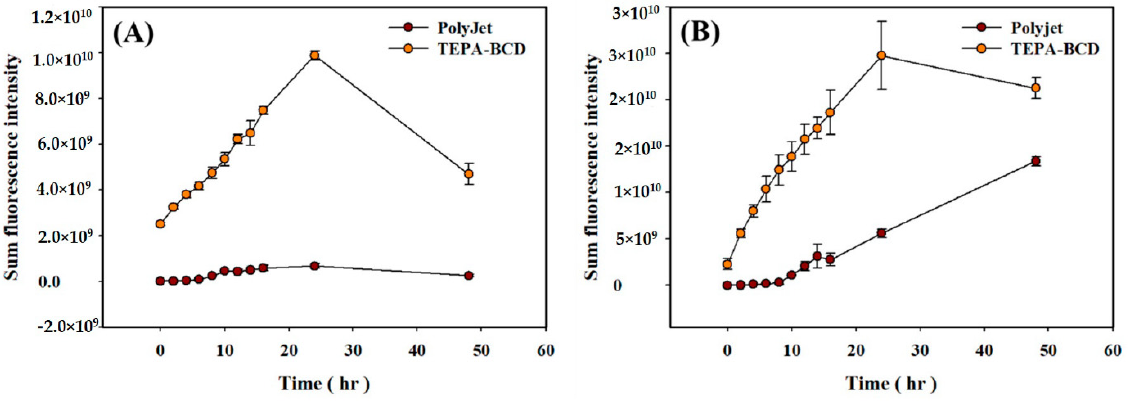
Figure 5. Kinetics of GFP expression. ARPE ( A ) and 3T3 cells ( B ). The cells were transfected with GFP-encoded plasmid DNA using PolyJet or TEPA-BCD (prepared at the DNA:nanoparticle ratio of 1:1.28 ( w / w )) as the transfection reagent. Error bars represent the standard deviation from 8 images. 1.2 × 10 − 10 Table 1. Effects of endocytic inhibitors on DNA uptake and siRNA gene silencing.